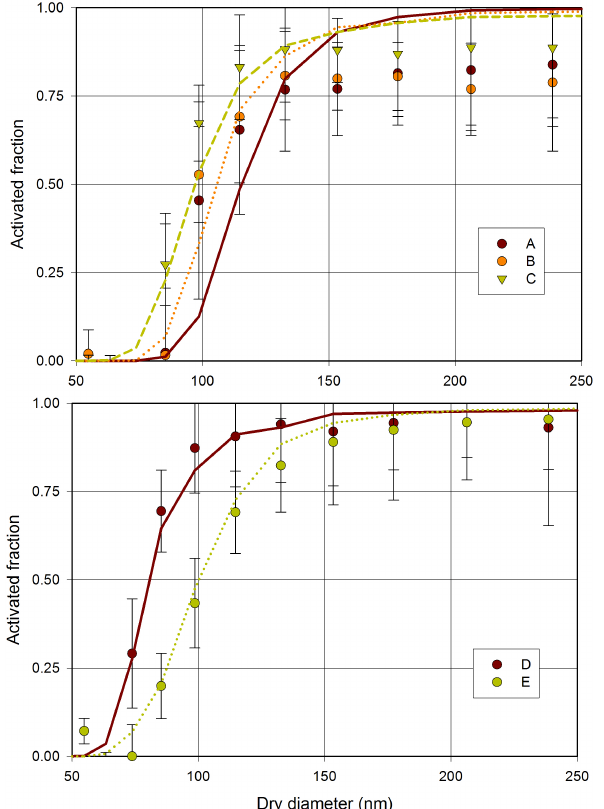
Fig. 6. The measured (symbols) and calculated (lines) activated fractions of aerosols as a function of the particle dry diameter for each cloud event (indicated in the legend). To ease the presentation, the events A–C and D–E are shown in separate plots.